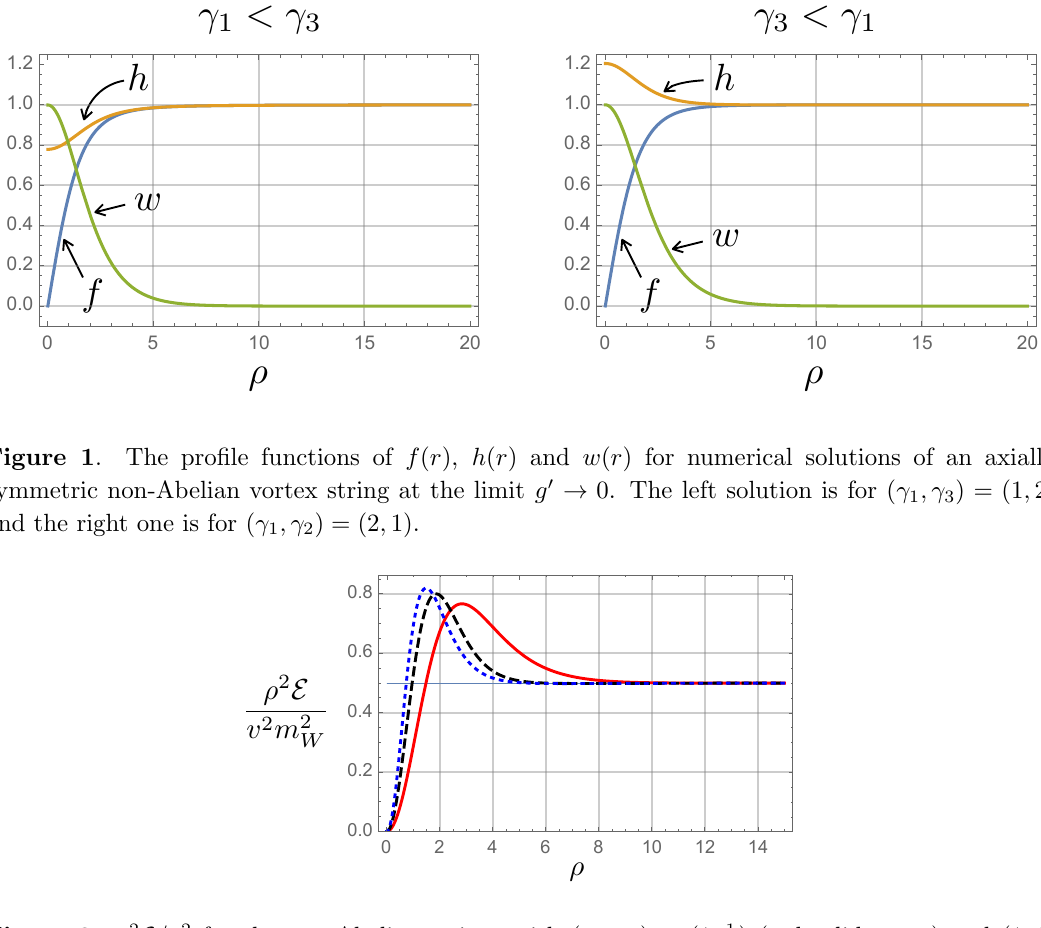
) (red solid curve) and (1 ; 1) 2